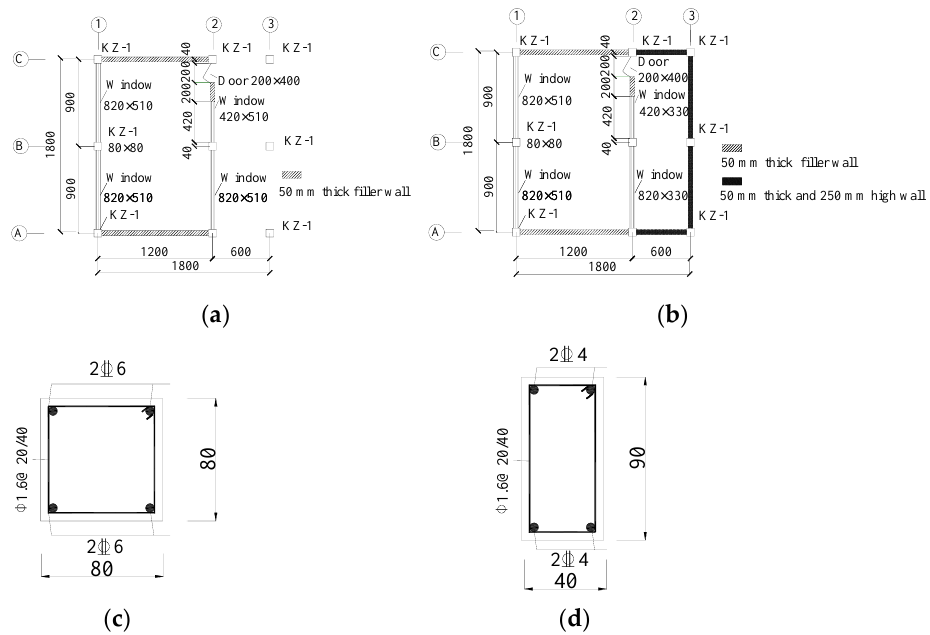
( b ) Figure 5. Axial spring in series model based on shear failure [23]. ( a )Axial spring model. ( b ) V P −  and H P −  curves. 3. The Prototype Structures and Numerical Models 3.1. The Prototype Structures of the Infilled RC-Frame Structure A three-dimensional model for a four-story infilled RC frame was selected as the case study for the influence of the axial – shear – bending interaction of RC columns on the seismic behavior of structures. The infilled RC frame was used as the case study building, which is a teaching building and located in a seven-degree seismic area in China. The seismic fortification has a basic ground-acceleration value of 0.10 g, according to GB 50011 – 2010 [24]. According to Han et al. [25], the two bays in each direction were de-